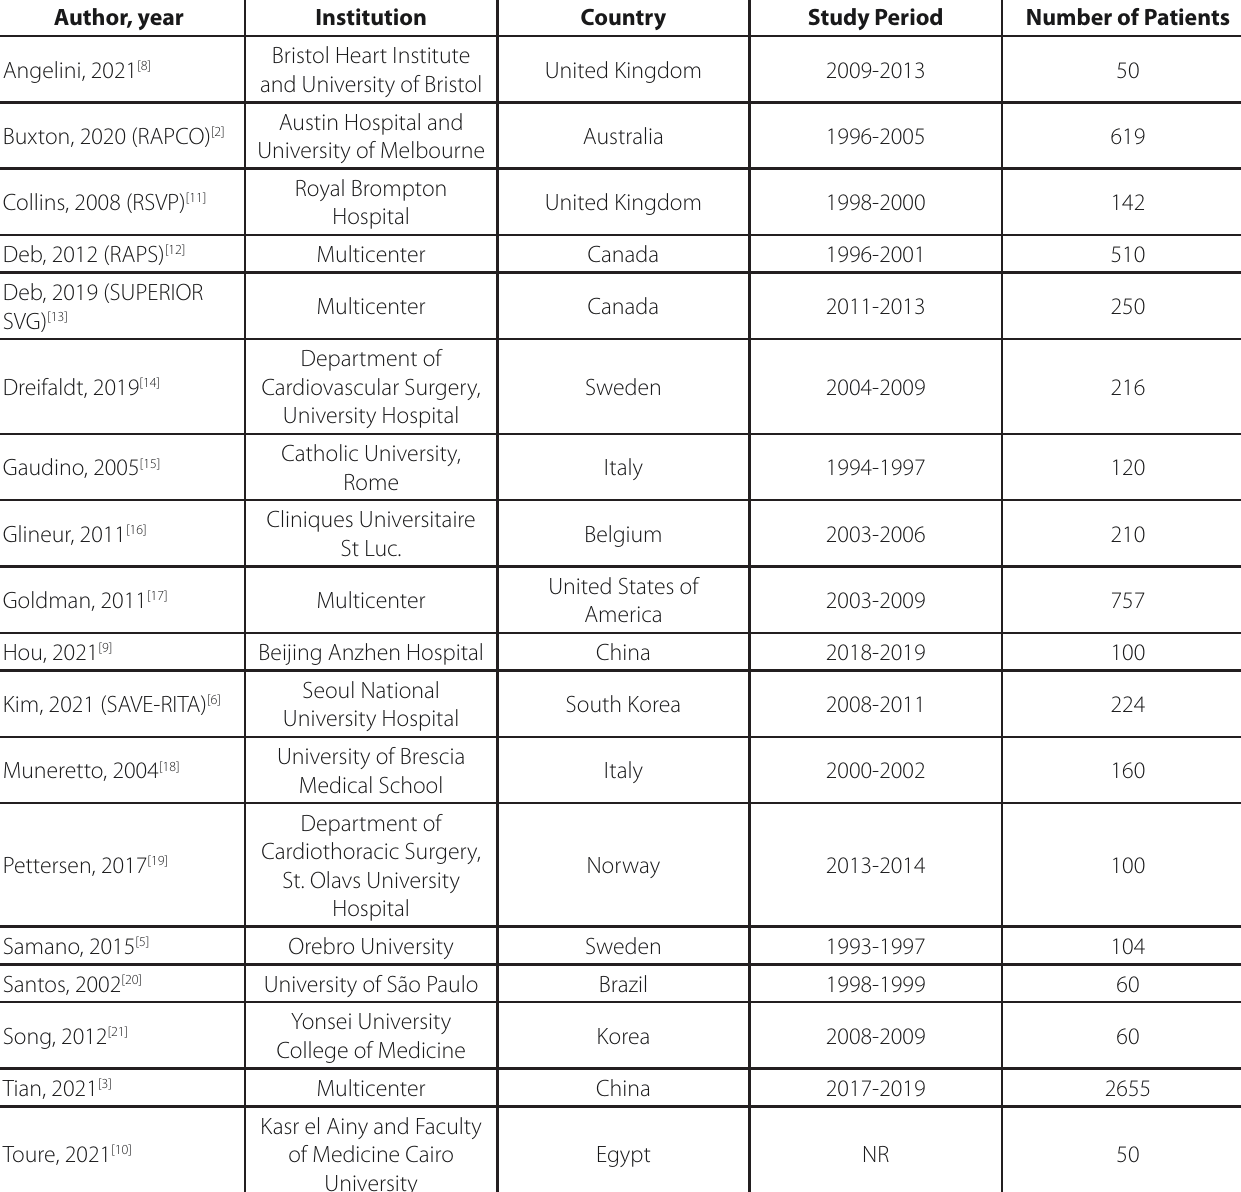
Table 1. Characteristics of included randomized trials.